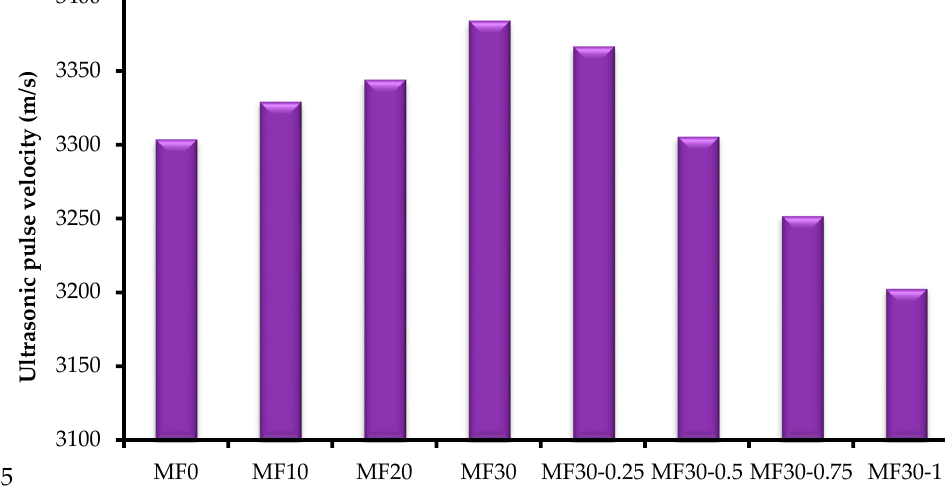
Figure 6. Ultrasonic pulse velocity.